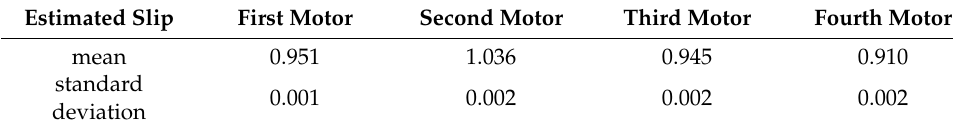
Table 2. The means and standard deviations of the estimated slip values in Figures 6–9.